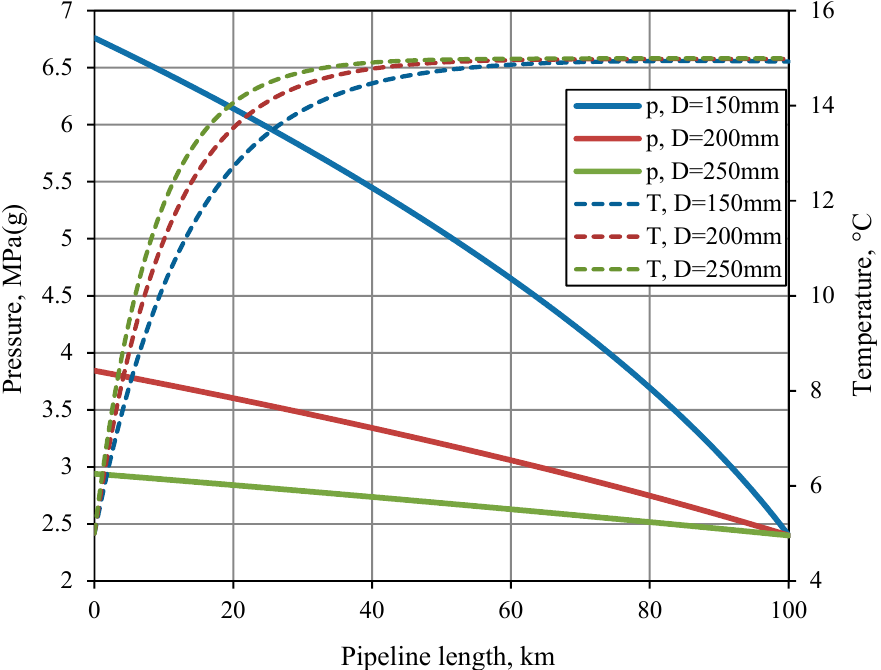
Figure 7. Pressure ( p ) (continuous lines) and temperature ( T ) (dashed lines) changes for hydrogen mass flow rate of 1.0 kg/s (40,000 Nm 3 /h) for different diameters.